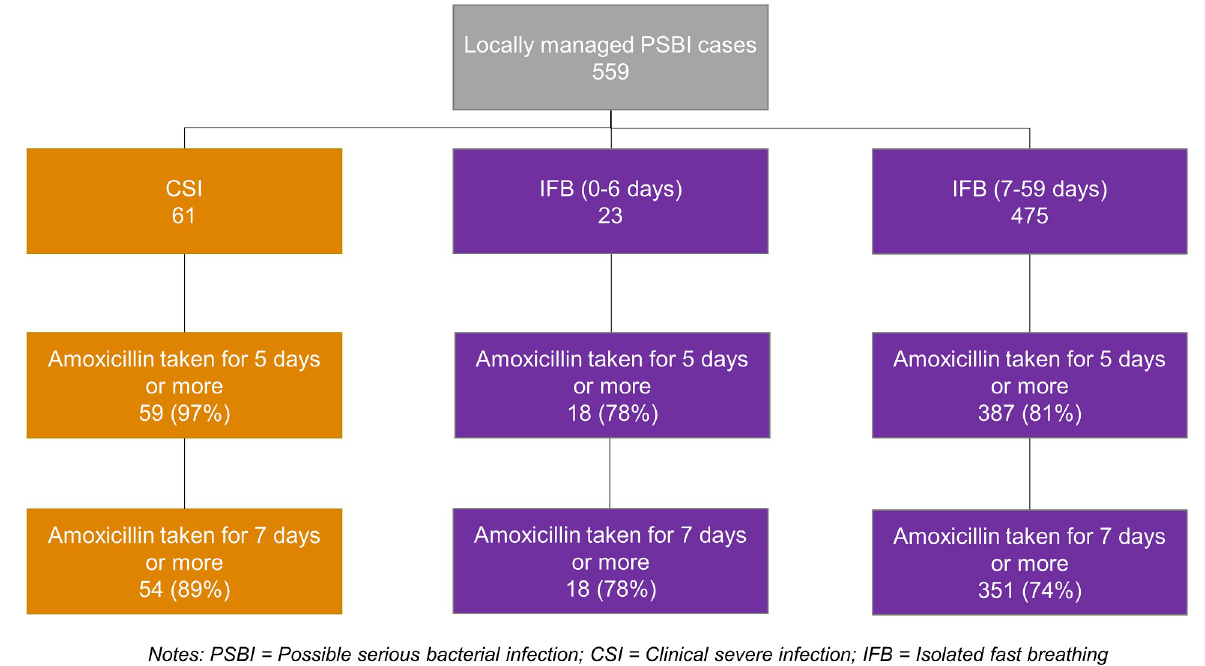
Fig 5. Caregiver report of adherence to treatment of sick young infants with PSBI (source: Community case tracking, N = 559).